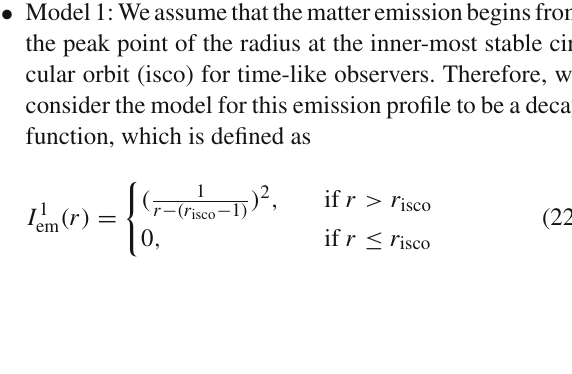
tion flow velocities are sub-Eddington with large opaque but ignore those with high accretion velocities and mass